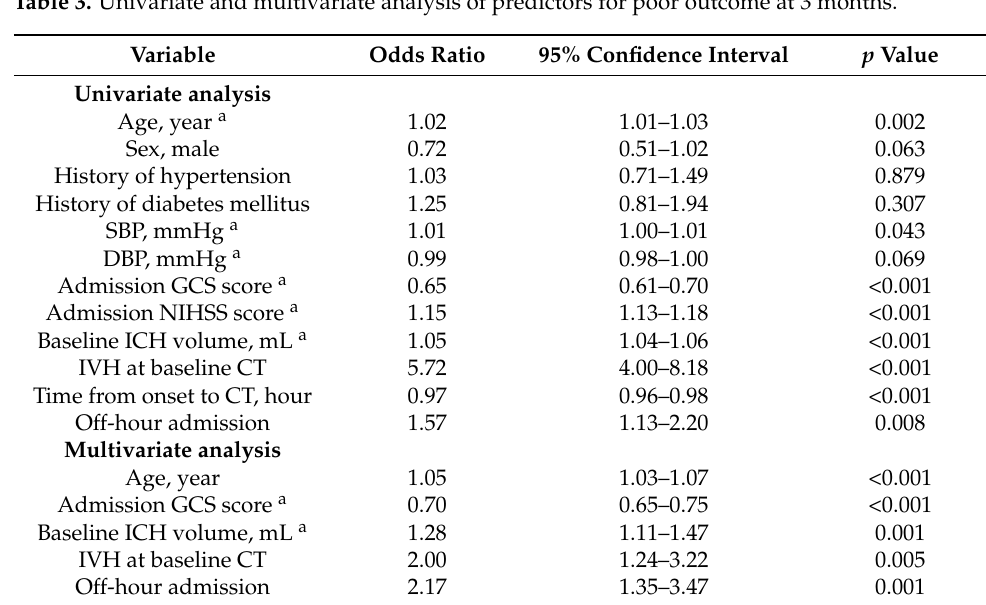
Figure 1. Distribution of modified Rankin Scale score in patients with on-hour admission and off-hour admission. Table 3. Univariate and multivariate analysis of predictors for poor outcome at 3 months.